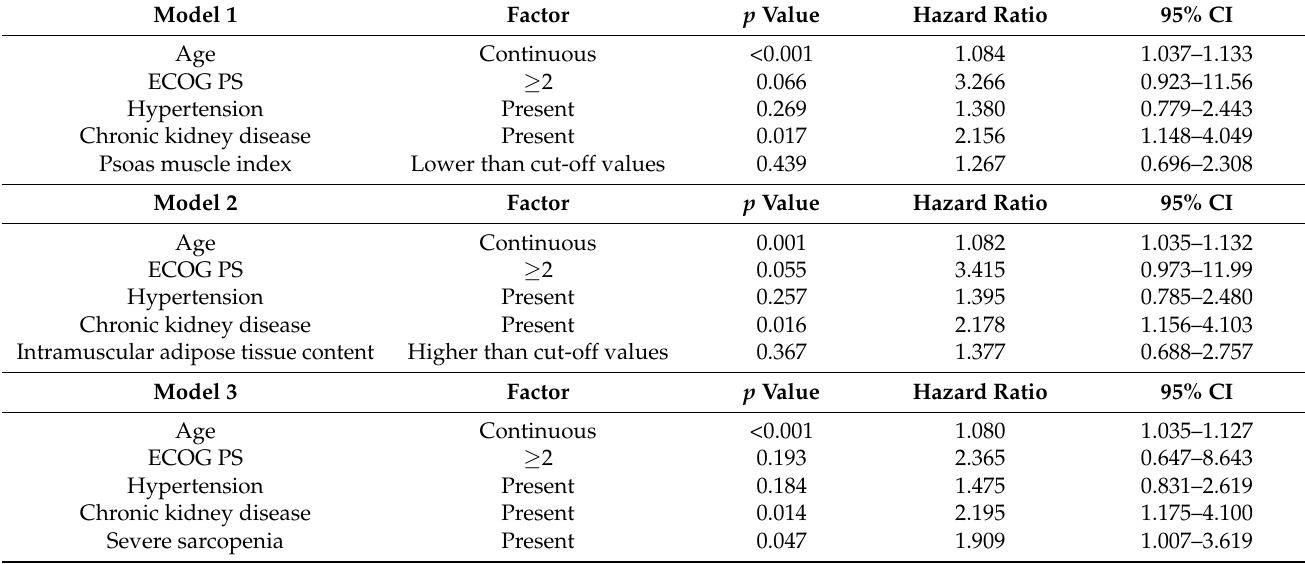
Table 3. Multivariable analyses for non-cancer-specific